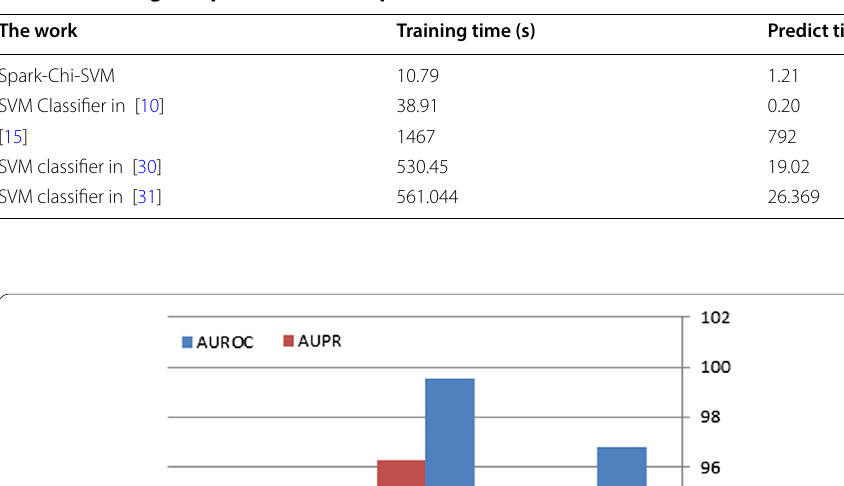
Table 7 Training and predict time comparative